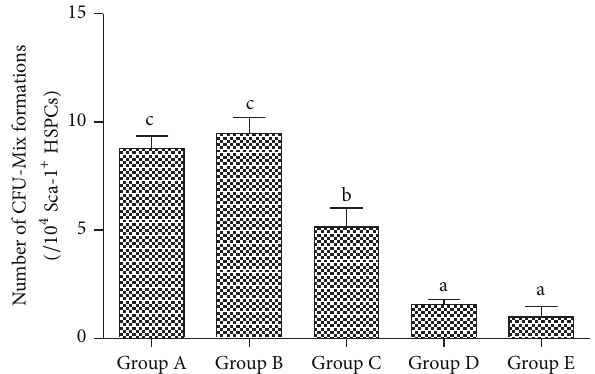
Figure 5: Number of CFU-Mix formations by Sca-1 + HSPCs. Group A: 3-4-week-old mice, 13–16g in body weight. Group B: 8-9-week- old mice, 20–25 g in body weight. Group C: 6-month-old mice, 35– 40 g in body weight. Group D: 12-month-old mice, 39–43 g in body weight. Group E: 18-month-old mice, 37–45 g in body weight. (a–c) represent a significant difference of these columns ( 𝑃 < 0.05